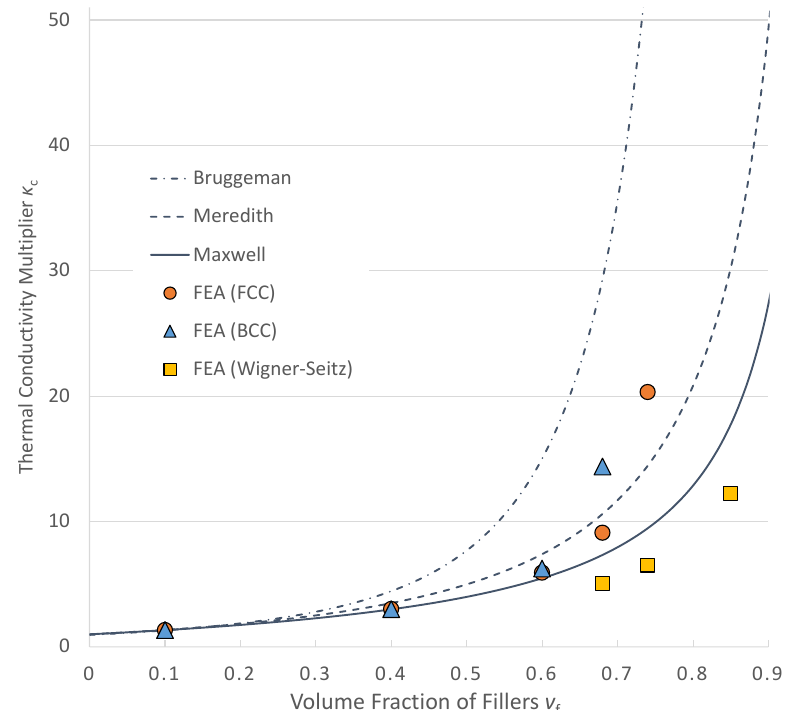
Figure 9. Comparison between results from FEA and theories.